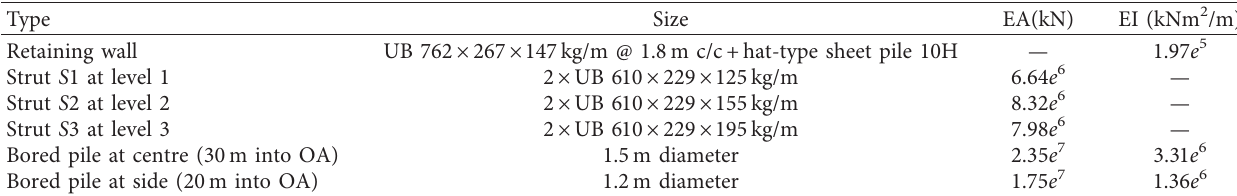
Table 1: Earth retaining wall system and their structural